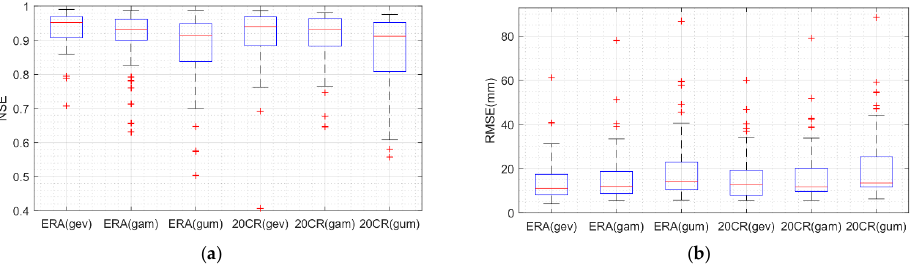
Figure 6. Boxplots of ( a ) NSE and ( b ) RMSE (mm) results for the AMRs of the bias corrected ERA ‐ 20c (ERA) and 20CR by QM approaches using three different distributions, GEV (gev), gamma (gam), and Gumbel (gum) in 48 stations. Table 3. Mean of error estimation results (RMSE (mm) and NSE) for the AMRs of the bias ‐ cor ‐ rected ERA ‐ 20c and 20CR by the QM approaches with GEV, gamma and Gumbel distributions (gevQM, gamQM and gumQM) in 48 stations from 1974 to 2010.